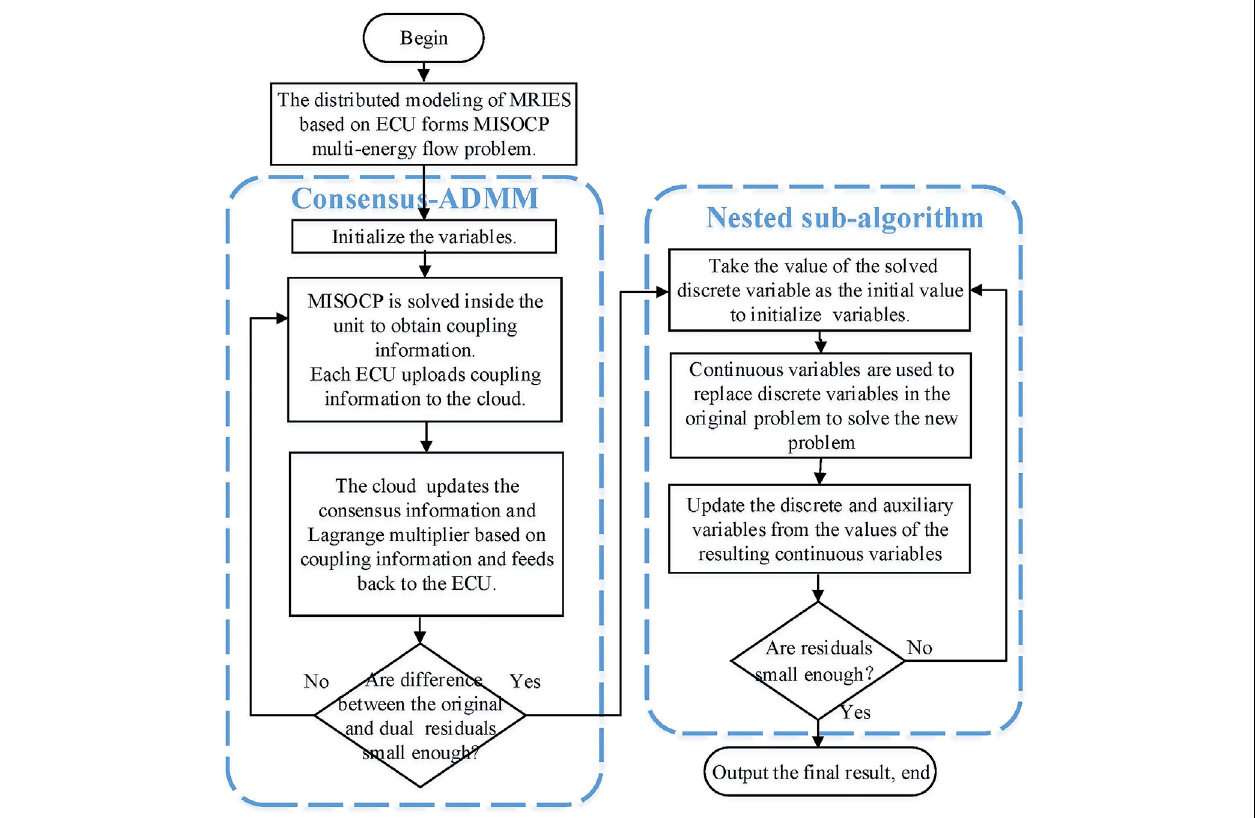
FIGURE 7 | Algorithm flow chart of the improved